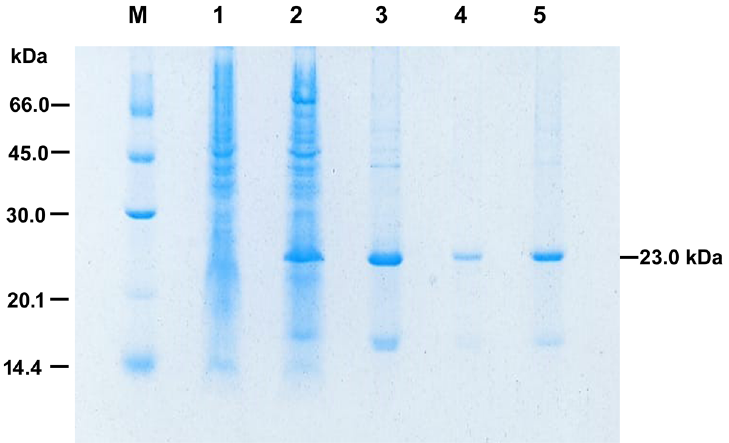
Figure 3. Expression, refolding at high pressure (HHP) and purification of rPilS analyzed by SDS-PAGE (15%). M: molecular mass standards; Lane 1: crude extract of E. coli cells before the addition of IPTG; Lane 2: crude extract of cells induced with 0.5 mM IPTG for 16 h at 30 °C; Lane 3: purified rPilS-IBs; Lane 4: soluble rPilS after refolding at high pressure (HHP) and Lane 5: rPilS purified by immobilized metal affinity chromatography.